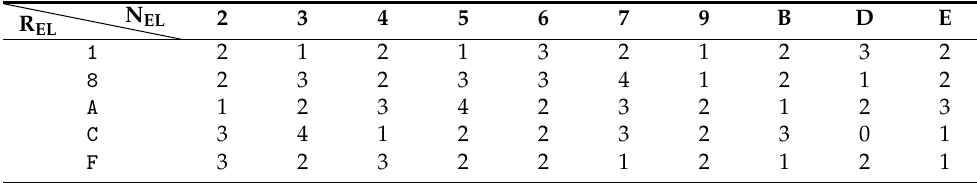
Table 3. Redundancy Analysis Table for x 3 over F 2 4